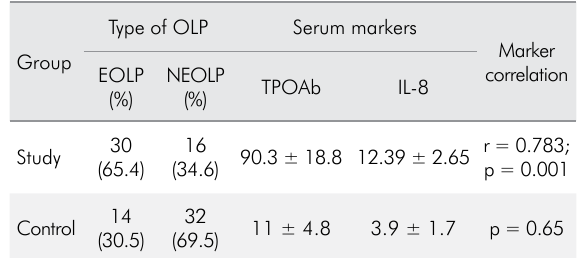
Table 2. Prevalence of clinical presentations of oral lichen planus (OLP) and the mean anti-TPO autoantibodies (TPOAb) serum levels (IU/ml) and IL-8 (pg/ml) in study and control